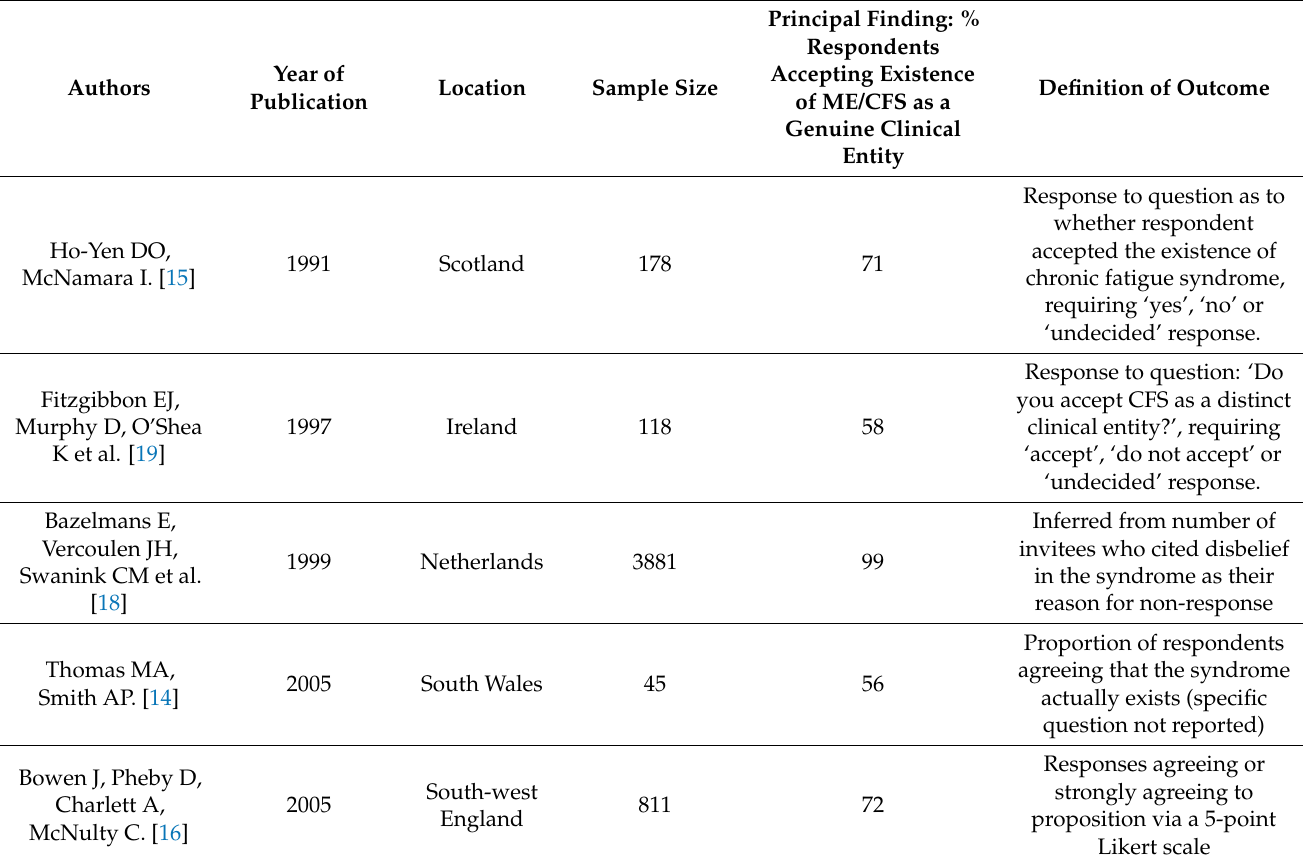
Table 3. Acceptance in general practice of ME/CFS as a genuine clinical